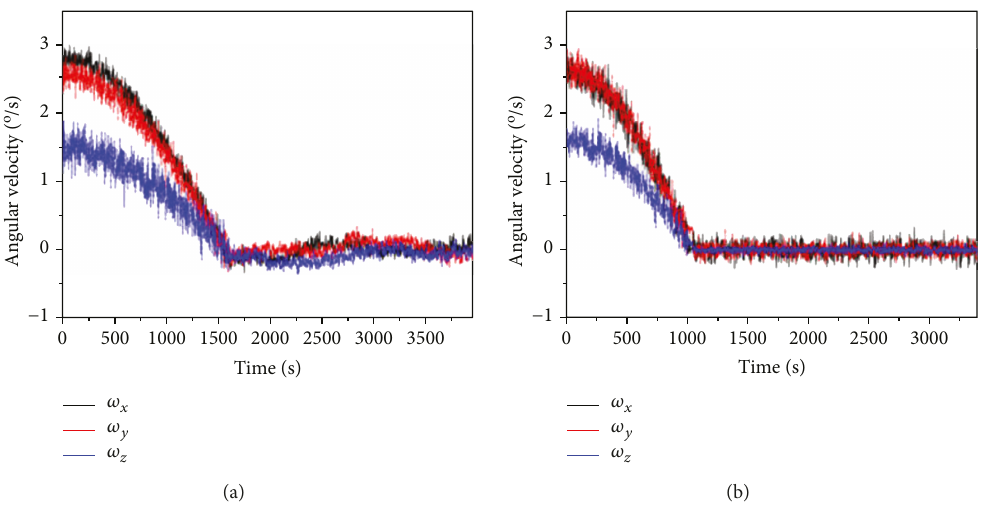
Figure 21: Angular velocity of on orbit attitude of Zhejiang University microsatellites: (a) A satellite and (b) B Table 25: The comparison of calculation and test results.